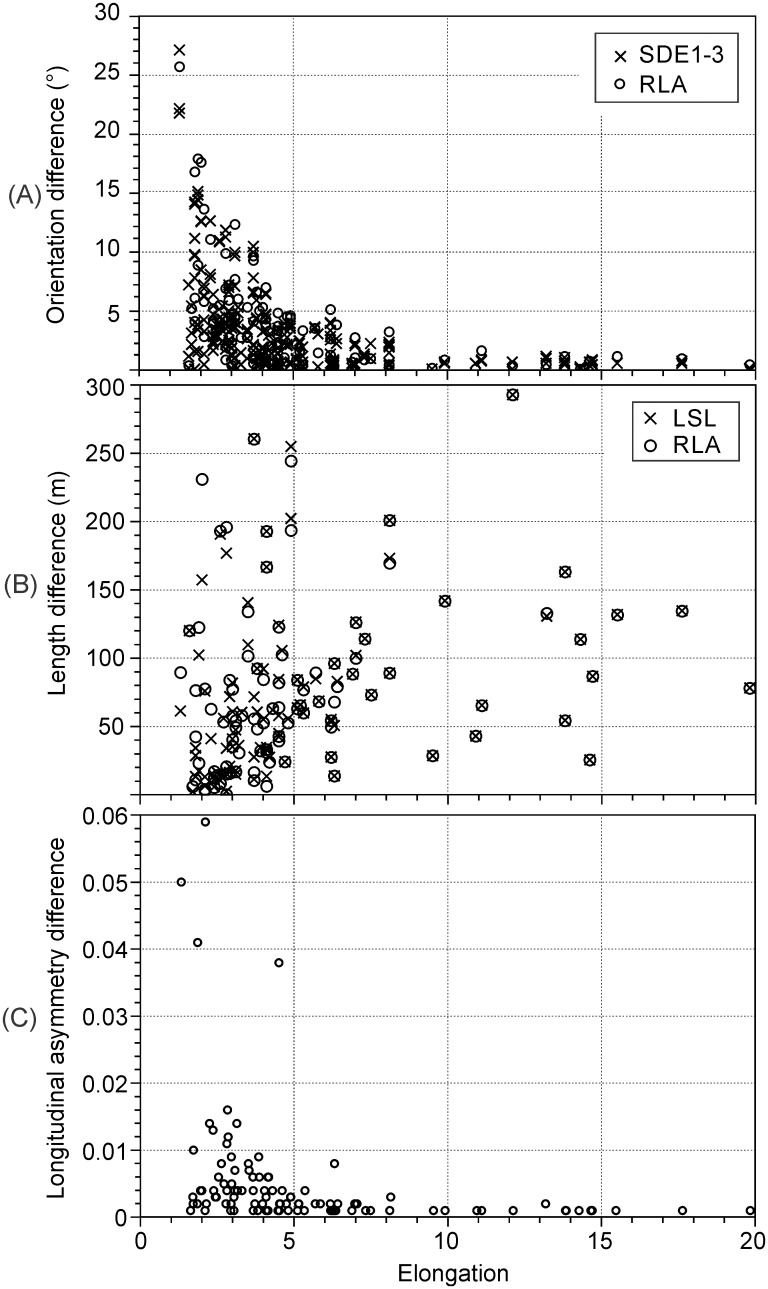
Relationship between footprint elongation and differences between morphometric measurement methods.A) Difference in orientation relative to the LSL method. B) Difference in length relative to elliptical length (Euler’s approximation). C) Difference between longitudinal asymmetry (ASPL_A [11]) computed using the LSL and RLA methods. Footprint elongation was calculated based on the minimum bounding rectangle.